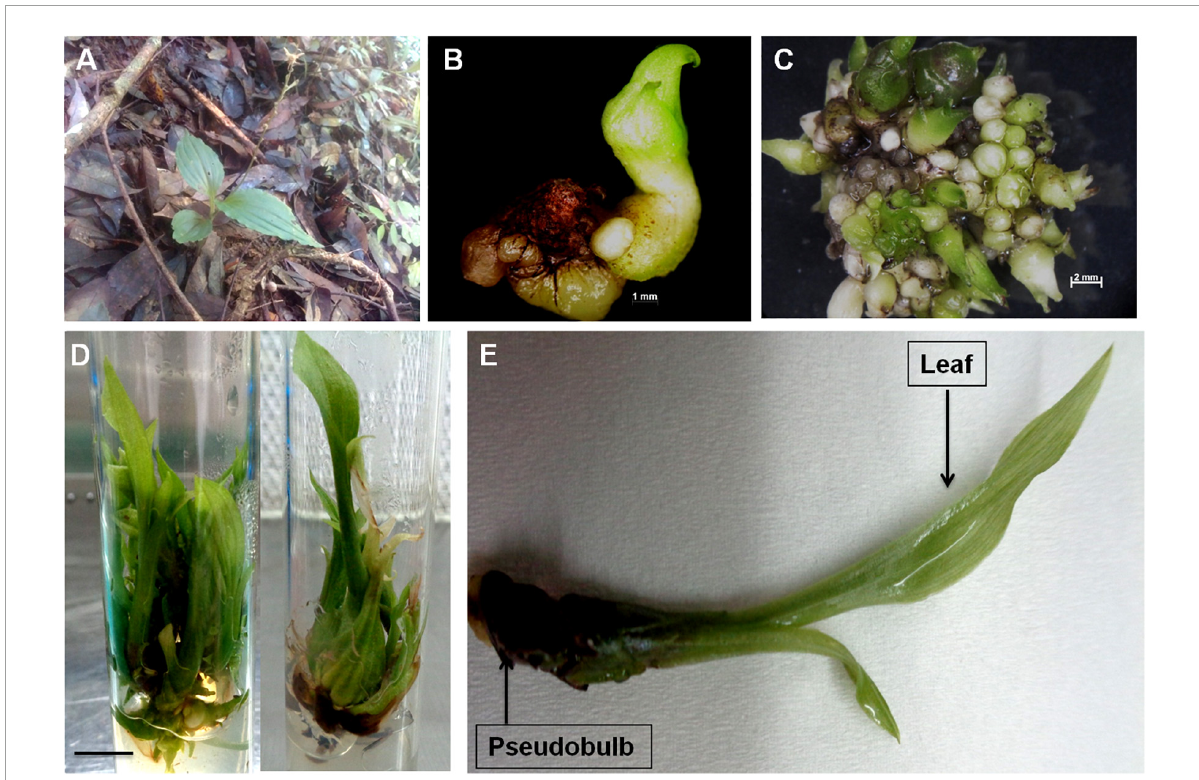
FIGURE2 (A) Wild plants of M. acuminata growing in natural habitat; (B) initiation of aseptic cultures using transverse thin cell layer ( t -TCL) explants (bar = 1 mm); (C) proliferation of protocorm like bodies (PLBs) from t -TCL explants and initiation of shoot buds (bar = 2 mm); (D) multiplication and growth of plants after 8 weeks of culture (bar = 1 cm); and (E) full grown plant of M. acuminata with differentiated